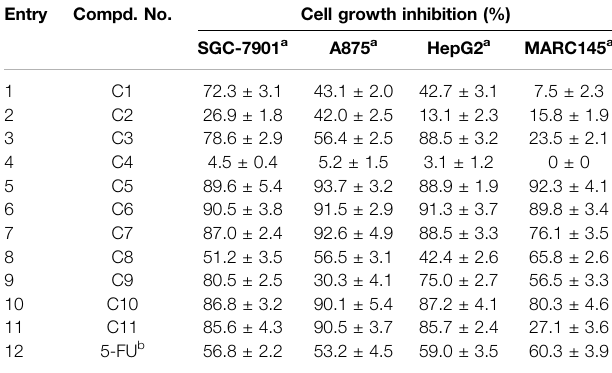
TABLE 2 | Cytotoxic activity (% cell growth inhibition) of compounds C1-11 at 100 µM. Entry Compd. No.